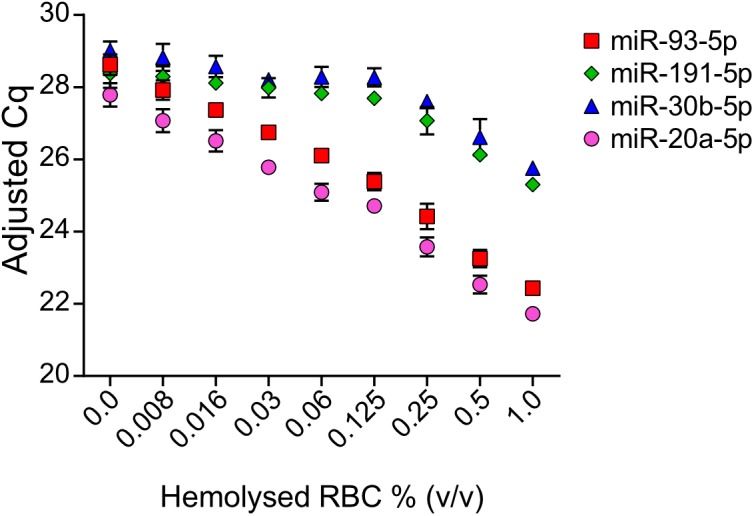
Raw Cq-values of endogenous miR-191-5p, miR-93-5p, miR-30b-5p, and miR20a-5p in serum spiked with hemolyzed RBCs. Values shown are mean Cq-values with SD from the three replicates. Raw Cq-values were adjusted according to UniSp4 in order to correct for variations in RNA extraction efficiency.